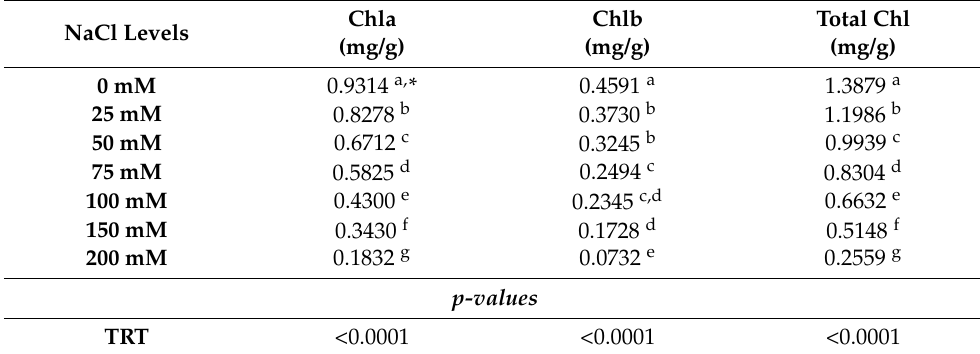
Table 3. Effect of different NaCl levels on chlorophyll content (fresh weight basis). NaCl